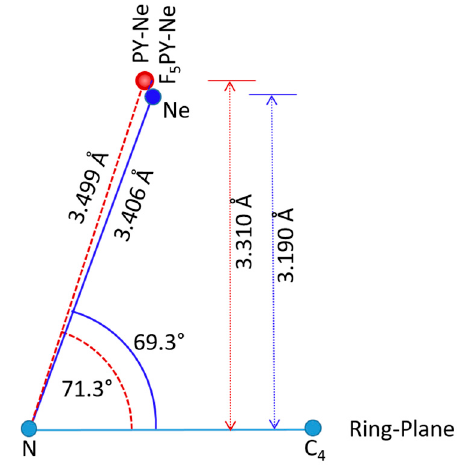
Figure 3. A sketch where the CCSD/6-311++G(2d,p) van der Waals predicted structure of F 5 PY-Ne (blue) is compared with that of PY-Ne (red) [20].